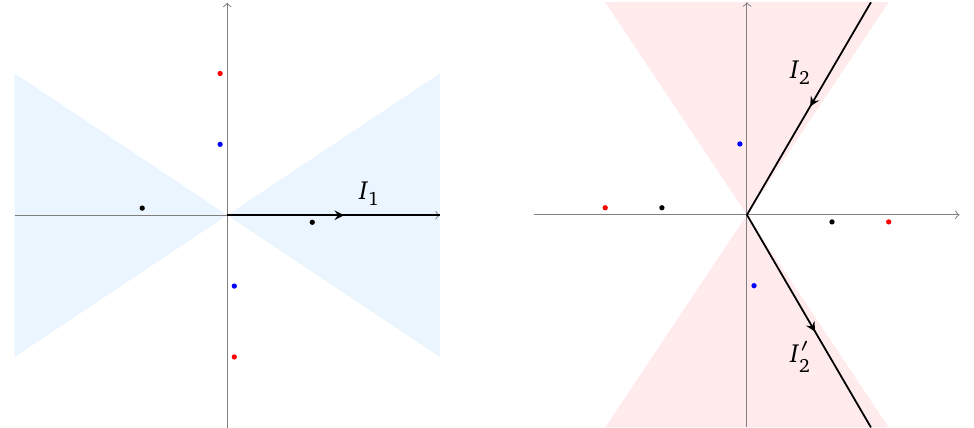
Figure 5: The blue (pink) regions is the convergent angular region Θ ( z ) for z = 1 + ε > 1 ( z = 1 − ε < 1). The black, blue or red dot is a representative for the s -, t - or u -channel poles at ω = ± m , ω = ± i